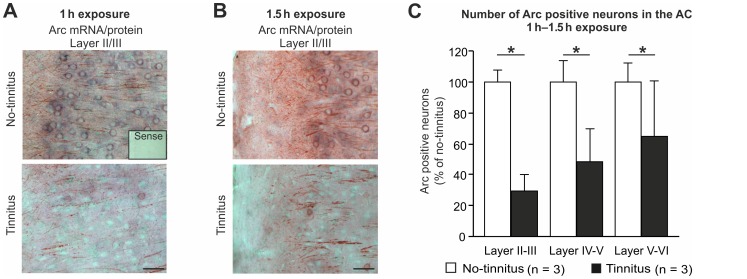
Silencing of Arc expression in auditory cortex (AC) in animals with tinnitus.(A, B) Double detection of Arc mRNA (blue) and Arc protein (red) in the AC of equally noise-exposed rats shows a significantly reduced expression in animals with tinnitus in all cortical layers, quantified in (C, unpaired Student´s t-test, p<0.001, alpha = 0.05, df = 6). Scale bars, 50 µm. n = 3 animals per group in three independent experiments. Images correspond to coronal sections 2.5 and 3.6 mm posterior to Bregma. Hybridization with sense riboprobes plus omission of the primary antibody produced no signals (insert in A, Sense).